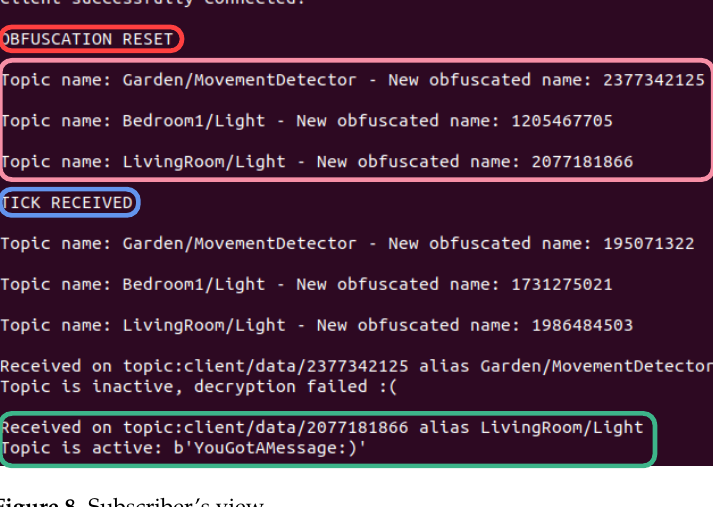
Figure 7. Publisher’s View